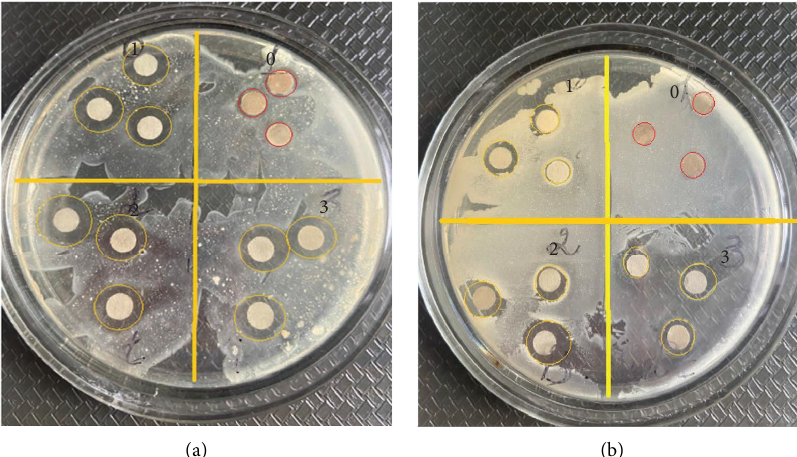
Figure 10: Antibacterial activity of “green” synthesized AgNPs via agar disk difusion Gram-negative bacteria ( Escherichia coli ) (a) and Gram-positive bacteria Bacillus subtilis (b): (1) distilled water, (2-3) synthesized AgNPs with grape pomace extract obtained by P-GPE, and (3) antibiotic (aztreonam) (Petri dishes were incubated at 37 ° C for 48